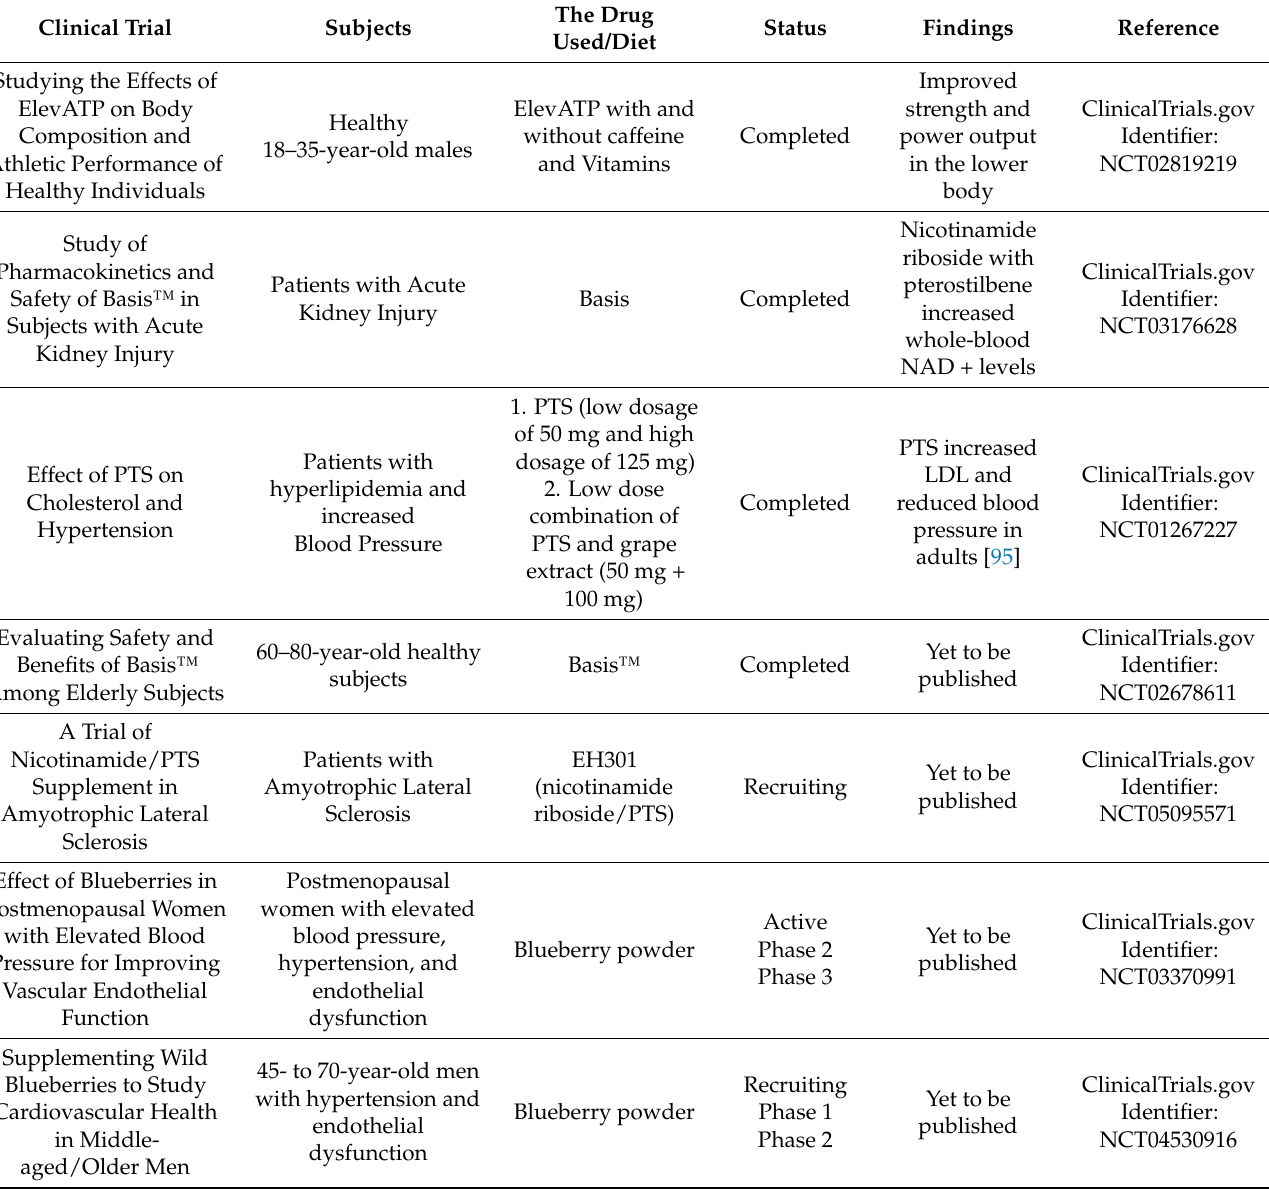
Table 3. Clinical Trials Involving